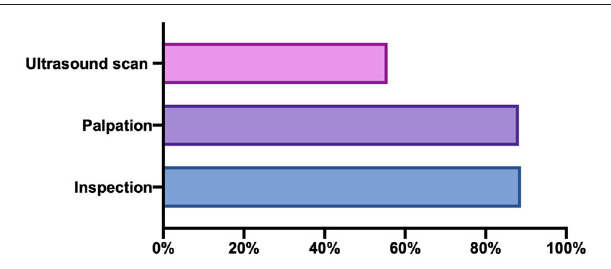
FIGURE 3 | Lipohypertrophy screening